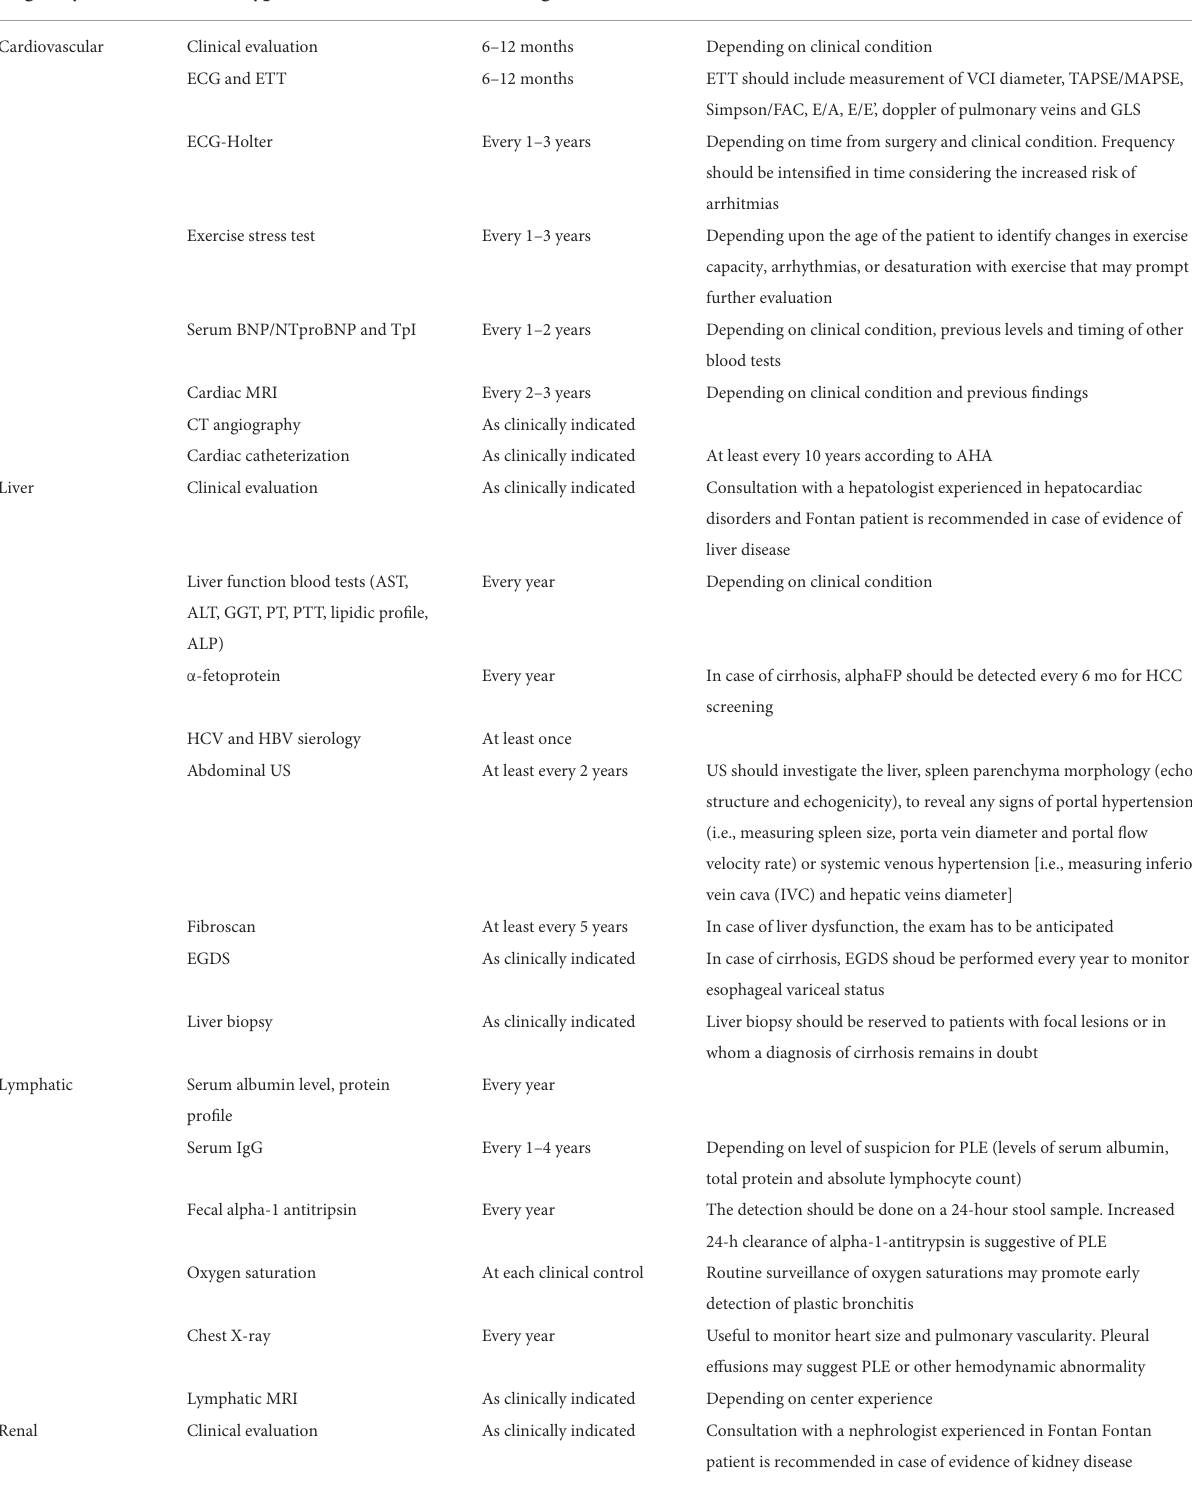
TABLE 1 Proposed organ system surveillance